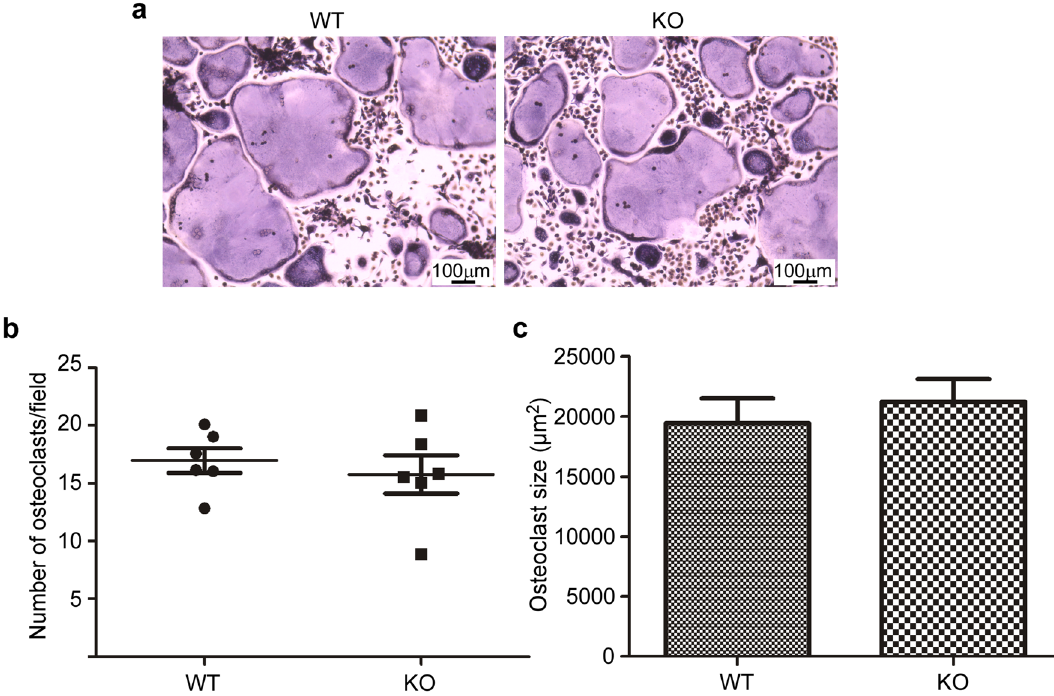
Figure 1. Hyal1 inactivation does not affect the differentiation of osteoclasts in vitro. ( a ) WT and Hyal1 knockout (KO) osteoclasts were differentiated for 7 days on glass coverslips before staining of the osteoclast marker TRAP (Fast Garnet GBC method). ( b ) The osteoclasts were counted as the number of TRAP-positive cells containing 3 or more nuclei. The quantifications were made on 25 images collected from 2 technical replicates for each mouse (n = 6 mice in each group). The graph shows the number of osteoclasts per field for both genotypes (mean ± SEM). ( c ) The size (surface) of WT and KO osteoclasts differentiated on glass coverslip was measured as the average of 60 cells for each mouse (n = 5 mice per group). The graph shows the means ± SEM. Two-tailed Mann–Whitney U tests indicate that there is no difference between the groups for these measurements ( b , c